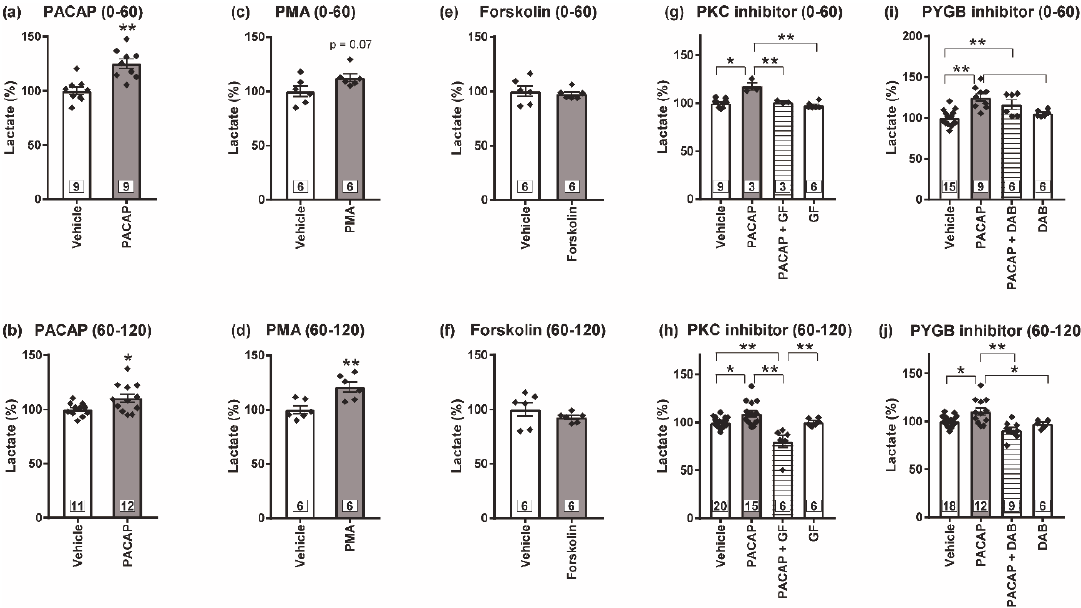
Figure 4. A crucial role of PACAP/PAC1 receptor/PKC-induced glycogenolysis in the L-lactate secretion from cultured spinal astrocytes. After the treatment with PACAP (1 nM) ( a , b ), PMA (100